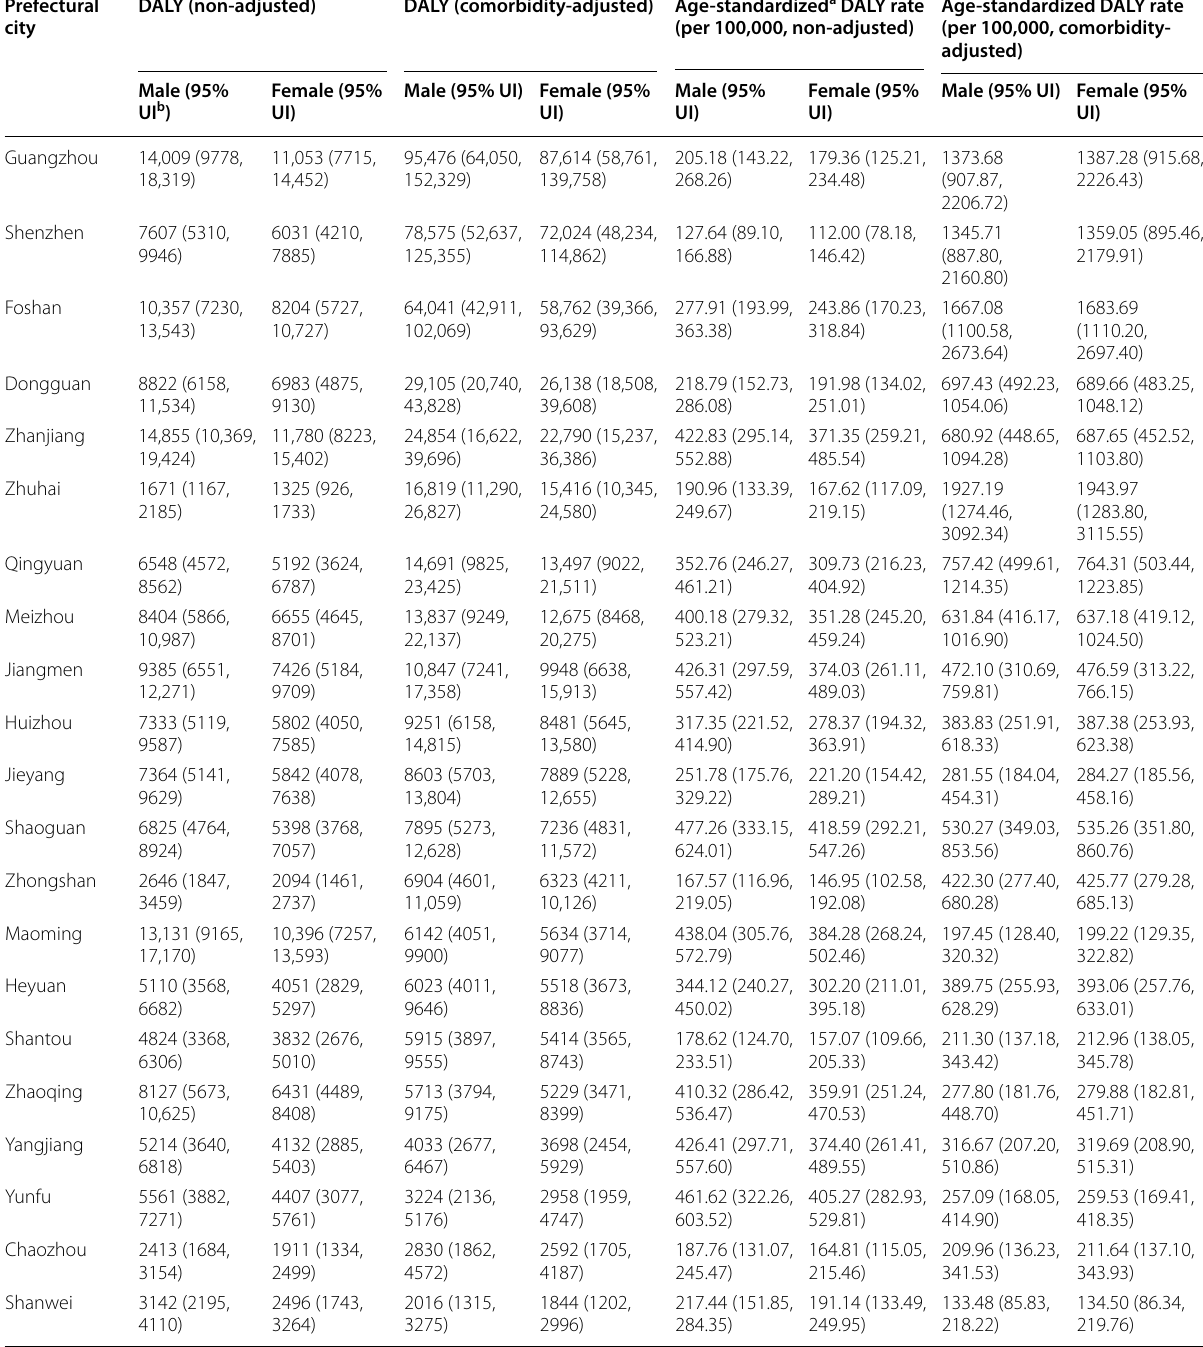
Table 2 Average disability-adjusted life-years (DALYs) for patients with severe mental disorders in Guangdong, China, during